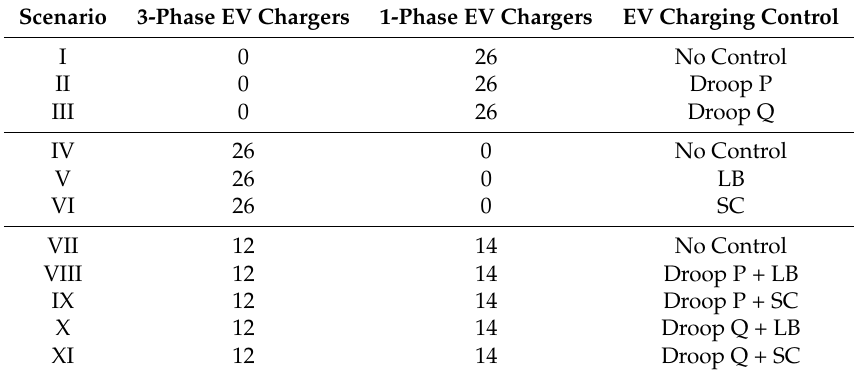
Table 3. Simulation scenarios conducted. LB, Load Balancing; SC, Sequence Compensation.